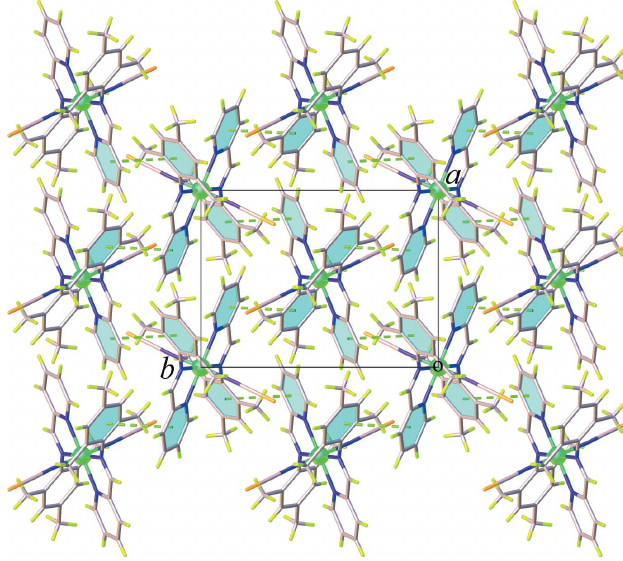
Figure 4 View of chains in ( I ) generated through C—H (cid:4)(cid:4)(cid:4) S and C—H (cid:4)(cid:4)(cid:4) (cid:2) interactions.